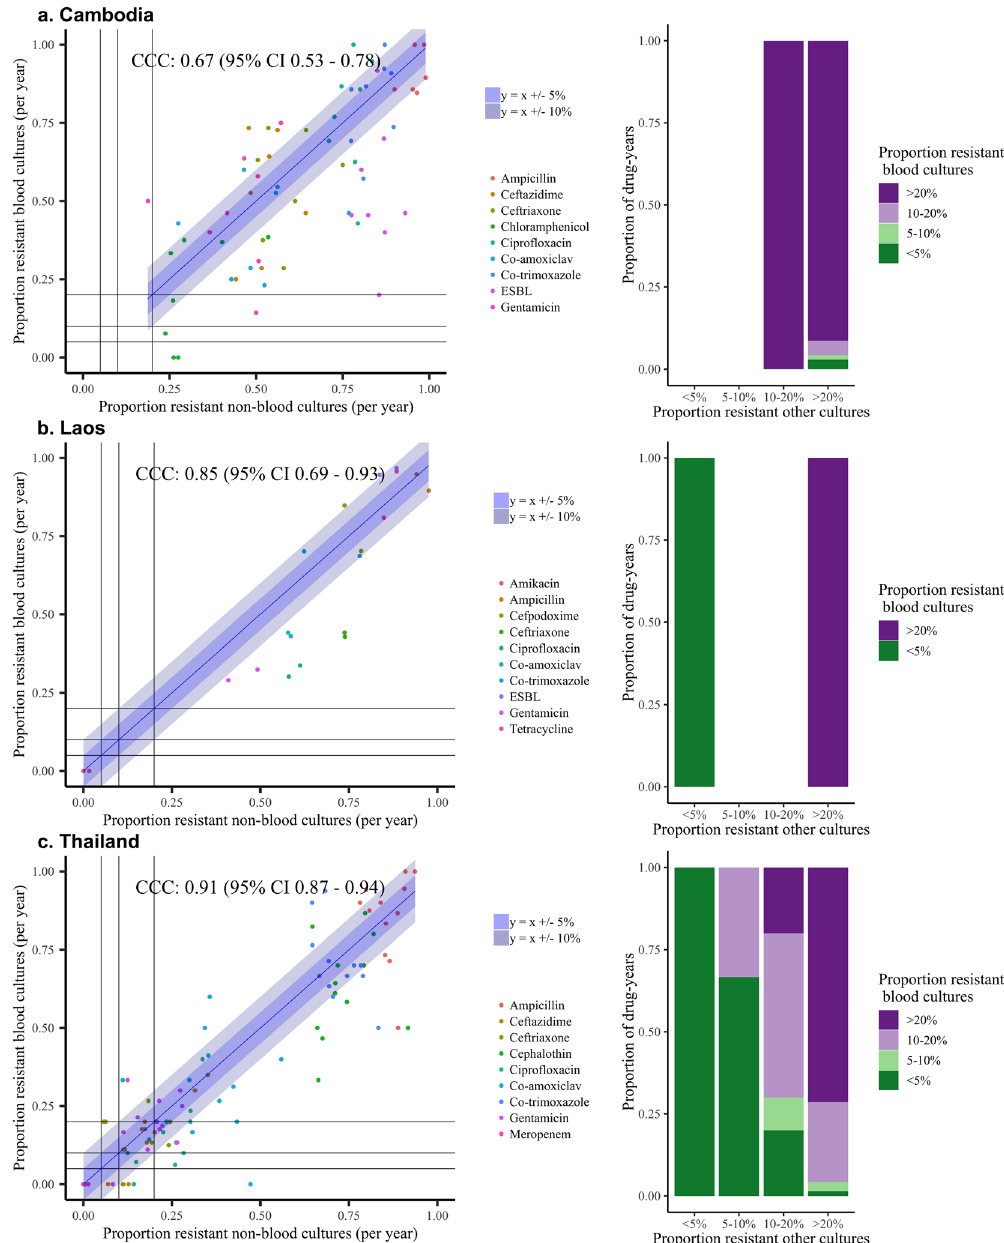
Figure 6. Association between resistance prevalence in E. coli blood versus urine cultures in three hospitals/ programmes in LMICs. Left: Scatterplot of the proportion of resistant non-blood cultures versus the proportion of resistant blood cultures per year for all antibiotics. Each dot reflects resistance prevalence for one antibiotic in one specific year, coloured by antibiotic type, with 21 dots per antibiotic (one for each year 1998–2018). Line of identity shown in blue, with associated ± 5% and ± 10% agreement discordance intervals. Additional lines are drawn to denote 0.05 (5%), 0.1 (10%) and 0.2 (20%) resistance prevalence thresholds for blood (horizontal lines) versus non-blood (vertical lines) cultures for ease of visualisation of agreement between clinically meaningful resistance categories in these two types of samples. Right: Stacked bars representing the data in the left-hand panel grouped as categorical resistance prevalence ranges, classifying resistance prevalence in blood cultures by the proportion in urine/non-sterile site (i.e. non-blood) cultures